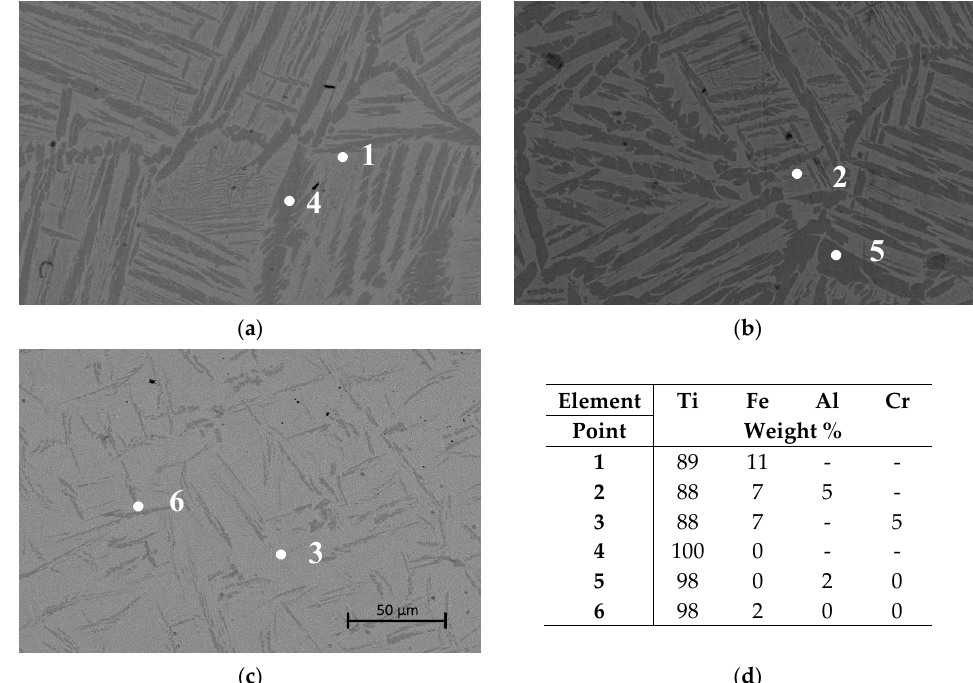
Figure 4. Sem images (BSE mode ×1000) of sintered samples ( a ) Ti ‐ 7Fe, ( b ) Ti ‐ 7Fe ‐ 3Al, ( c ) Ti ‐ 7Fe ‐ 5Cr, and ( d ) EDS analysis on each specified point.